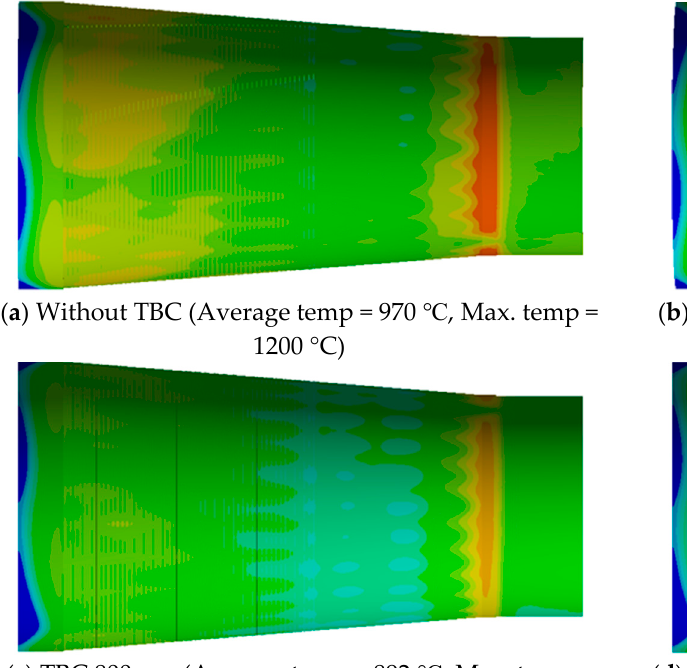
Figure 12. Inner CL metal surface temperature distribution (combustion side) based on the TBC thickness.